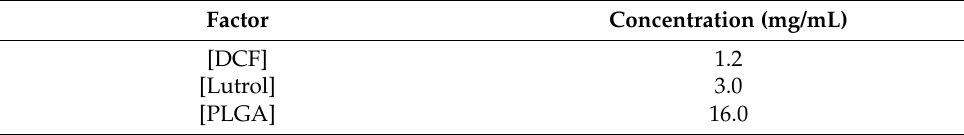
Table 2. Optimal Formulation DCF NPs.